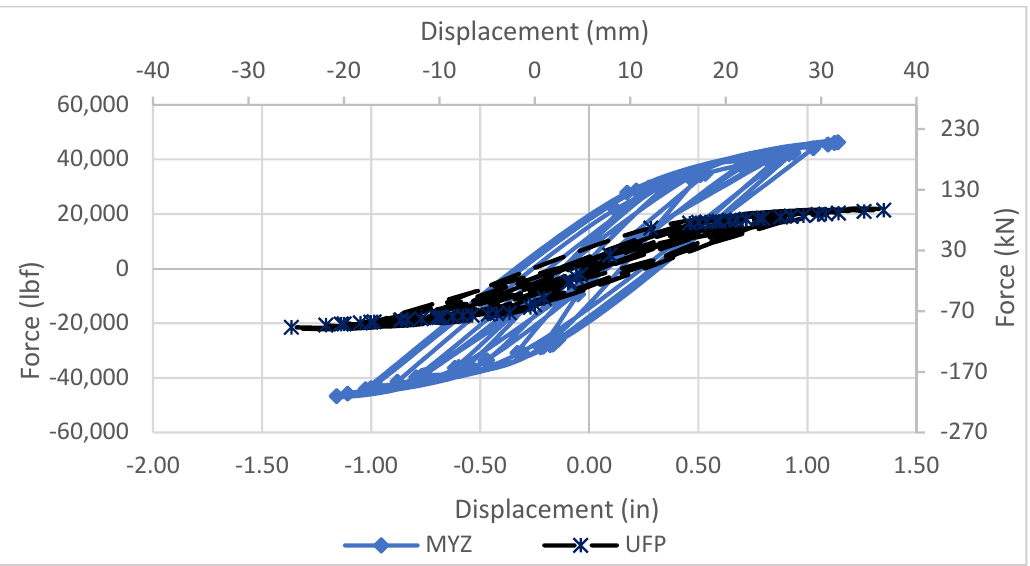
Figure 19. Connector force vs displacement in the UFP and MYZ connectors.